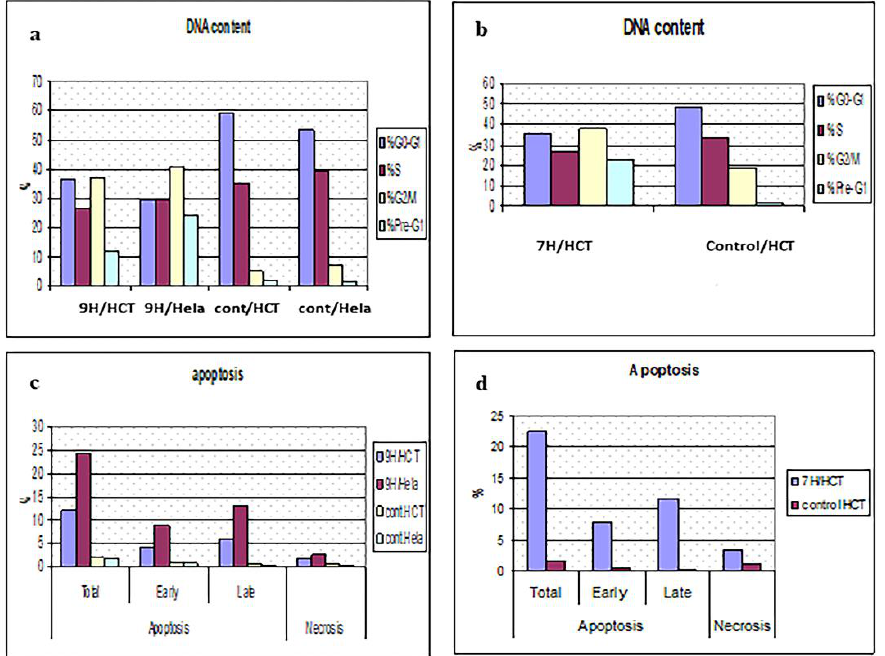
Figure 16. Cell cycle analysis and testing apoptosis. 9H/HCT: Colorectal cells treated with 9H (0.06 µ M), 9H/Hela: cervical cancer cells treated with 9H (0.19 µ M), Cont. HCT: untreated colorectal cancer control cells, Cont. HeLA: untreated cervical cancer control cells. 7H/HCT: Colorectal cells treated with 7H (1.95 µ M). ( a , b ) panels reveal that 9H & 7H compounds markedly decrease the percentage of HCT & HeLA cells in G0-G1and S-phase and increase their percentage in G2/M phase, compared to control cells, respectively. ( c , d ) panels show that 9H & 7H compounds markedly stimulate apoptosis in HeLA & HCT cells compared to control cells. Also necrosis is induced compared to control cells.